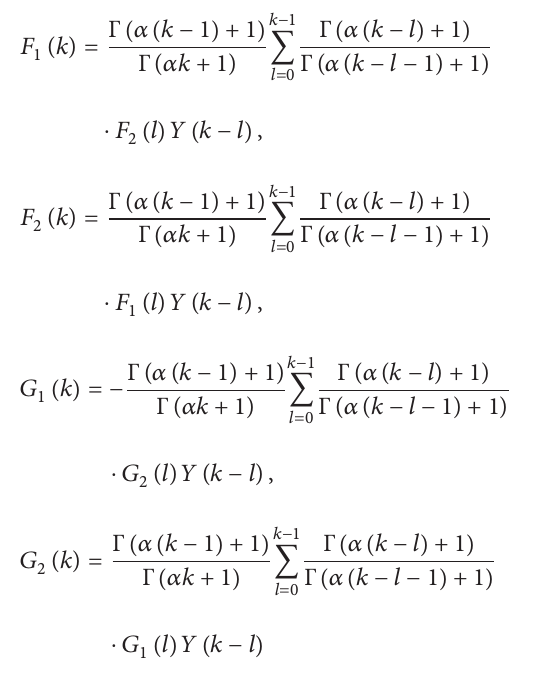
to obtain accurate approximations with 10 steps of iteration. Approximations of the solution 𝑦(𝑡) for different order of fractional derivatives are given in Figure 4. We set iteration number 𝑛 = 10 and summarize approximate solutions for 𝛼 = 0, 6, . . . , 0.9 . The numerical values are also given